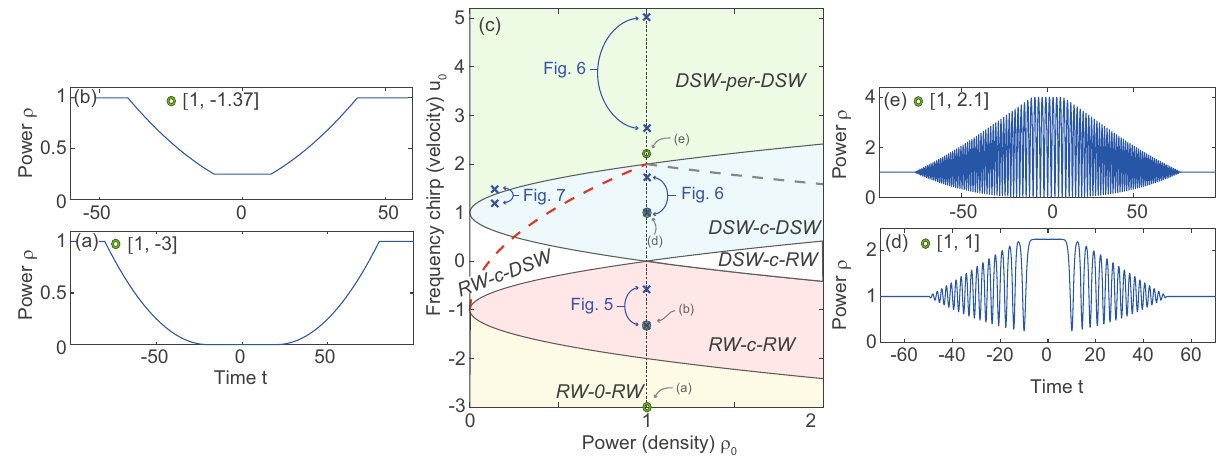
Fig. 3 The Riemann problem of the NLSE. c Dynamic transition diagram: domains in the plane of input parameters ( ρ 0 , u 0 ) of the step, giving rise to different wave-pair compositions of rarefaction (RW) and dispersive shock (DSW). The two waves in the pair can be connected through a constant state (-c-), zero density (vacuum state -0-); or an unmodulated nonlinear periodic wave (-per-). Above the red (gray) dashed lines, a vacuum is predicted to appear in the DSW-R (DSW-L). a , b and d , e are typical examples of output (normalized length z L = 20) from Whitham modulation theory marked with green circles in ( c ). Experimental results are marked with blue crosses. See also Supplementary Information for a video illustrating the transitions between all the cases along the ( ρ 0 = 1) vertical line and for an extended version of this fi gure where, for completeness, we also report former experimental results from ref. 32